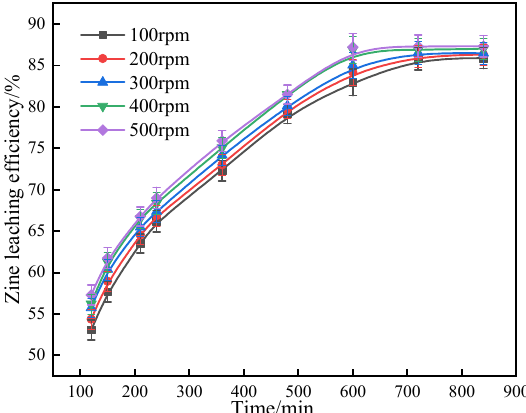
Figure 5. Effect of stirring speed on the zinc leaching efficiency.